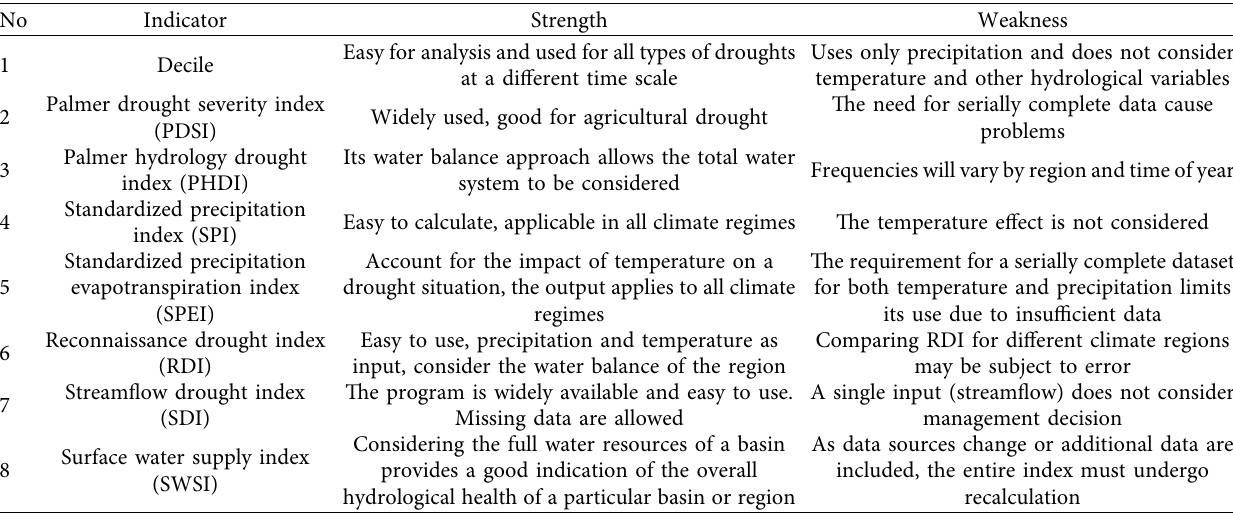
Table 2: Summary of drought indicator’s strengths and